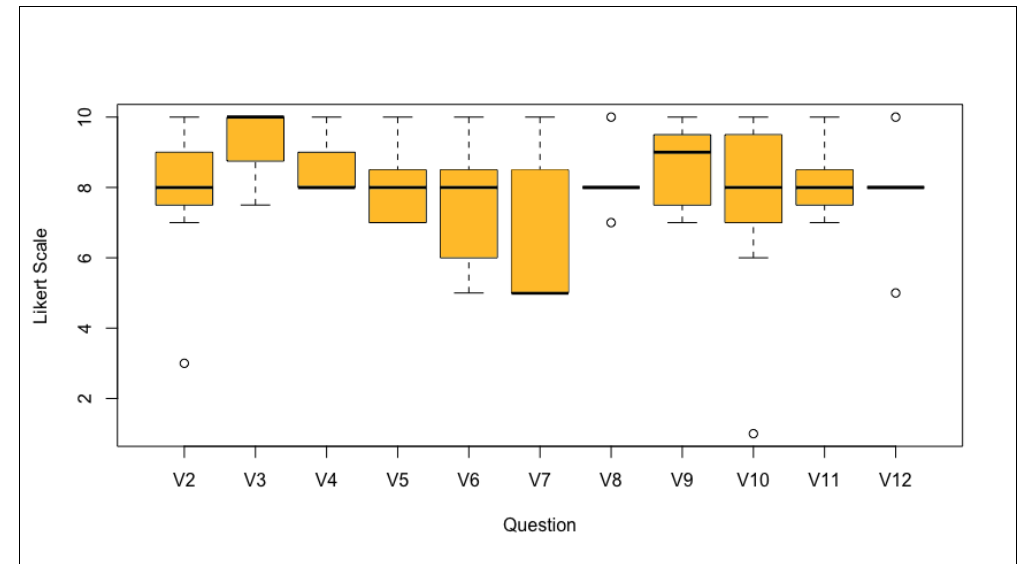
Figure 11. Results from questions about the overall level of acceptance of Version P compared to Version NP.